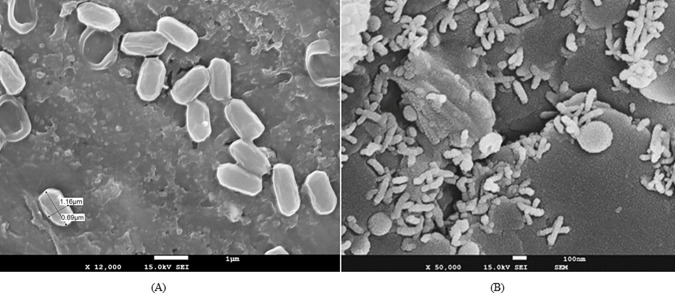
SEM of (A) P. ehimensis strain BS1 in BH medium, (B) Berea core plug used in the core flood experiment. The presence of isolate colonies P. ehimensis strain BS1 inside the core shows the potential of P. ehimensis strain BS1 in MEOR.